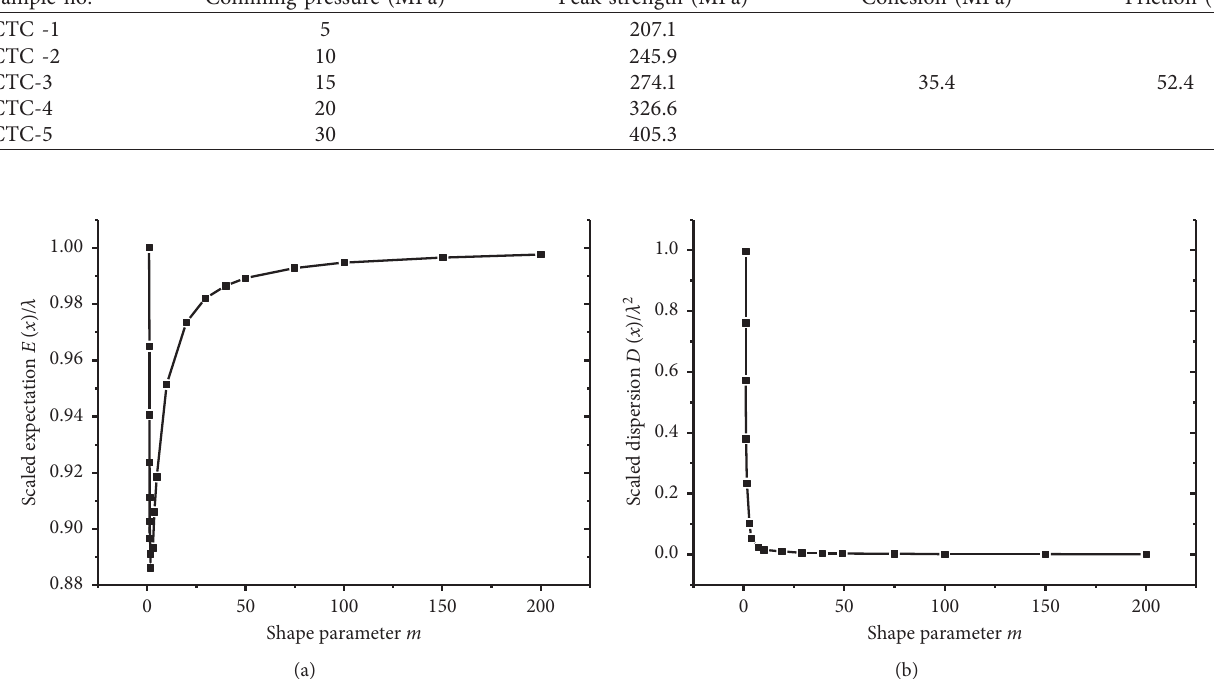
Figure 5: Scaled mathematical expectation (a) and dispersion (b) of the Weibull distribution with different shape